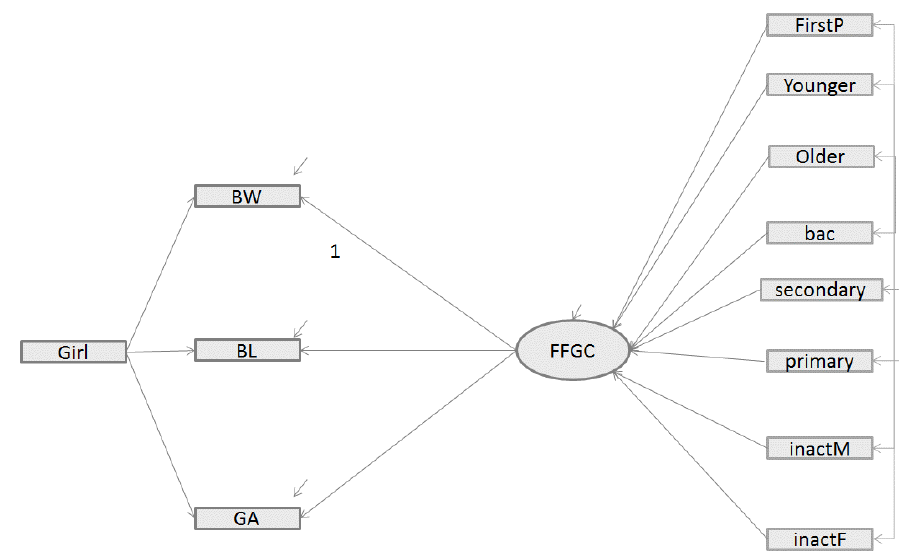
Figure 2. Structural equation model relating parents’ characteristics to those of an infant’s birth (BW, BL, GA) with a mediating latent variable FFCG (Model 2)